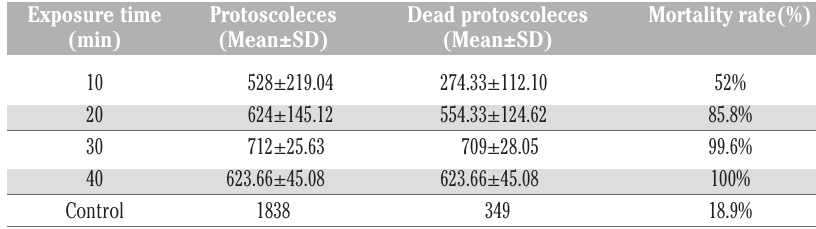
Table 2. Scolicidal effect of ginger ( Zingiber officinale ) extract at concentration of 50 mg/mL after various exposure times.